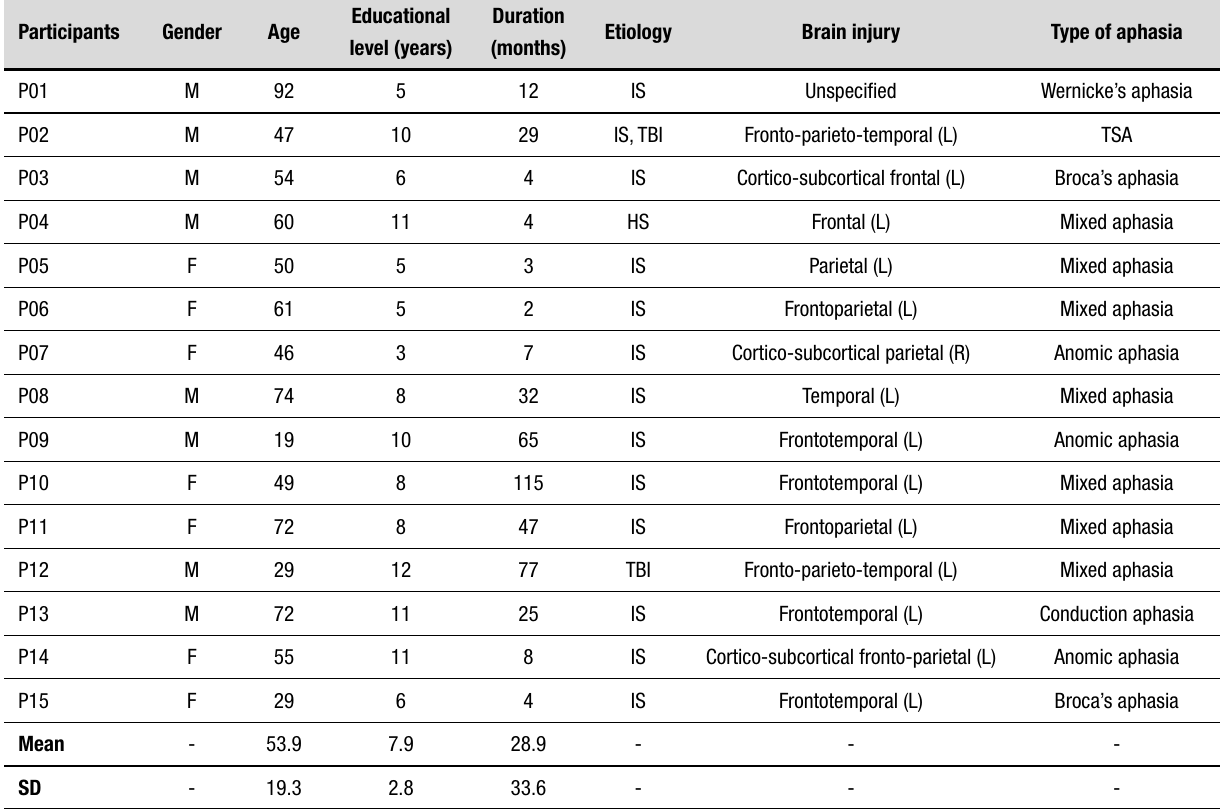
Table 1. Sociodemographic and clinical data from the